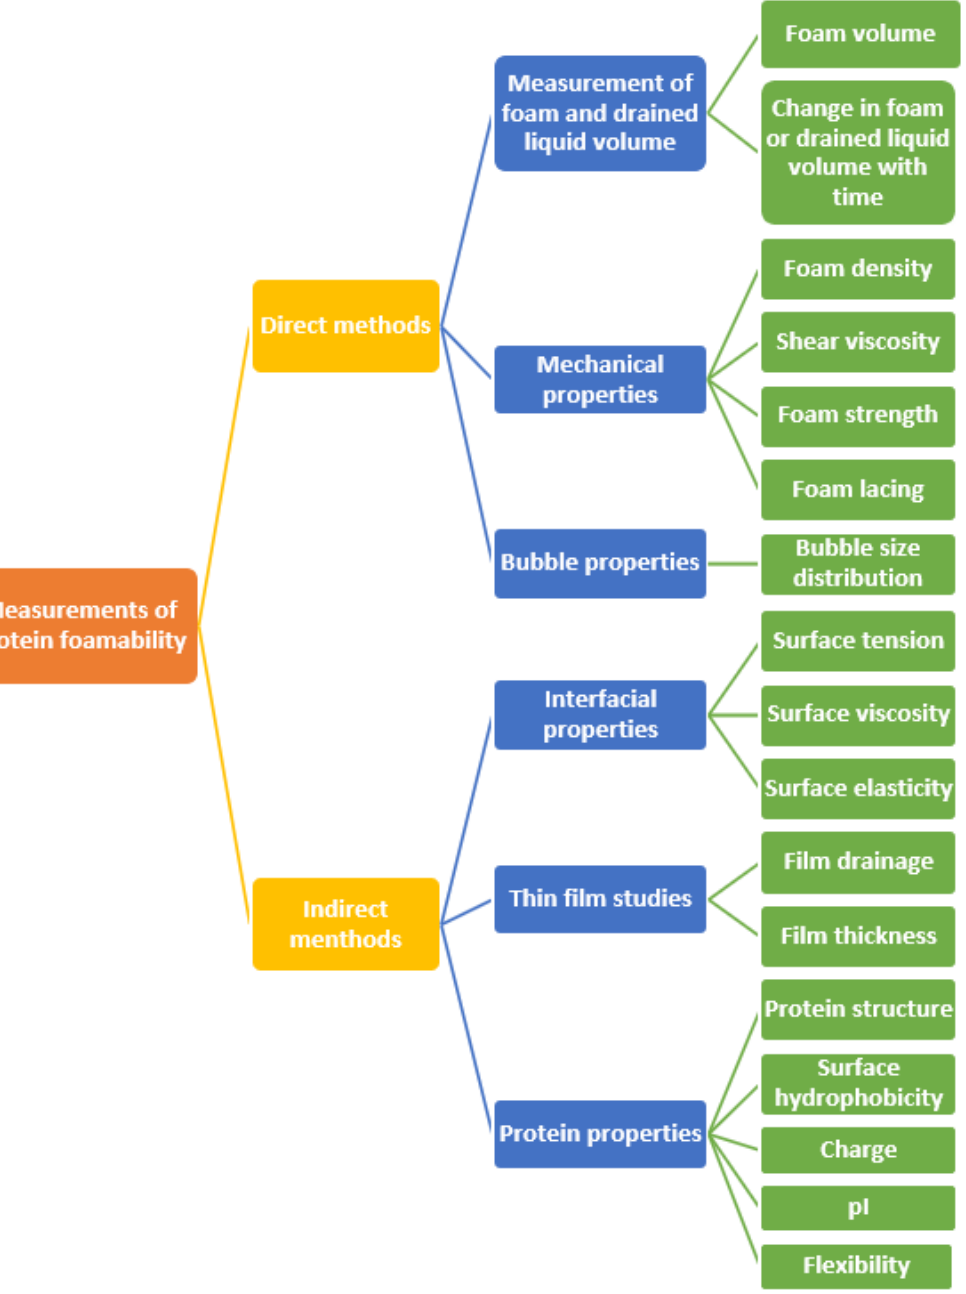
Figure 2. Common direct and indirect measurements of foam Figure 2 . Common direct and indirect measurements of foam properties.